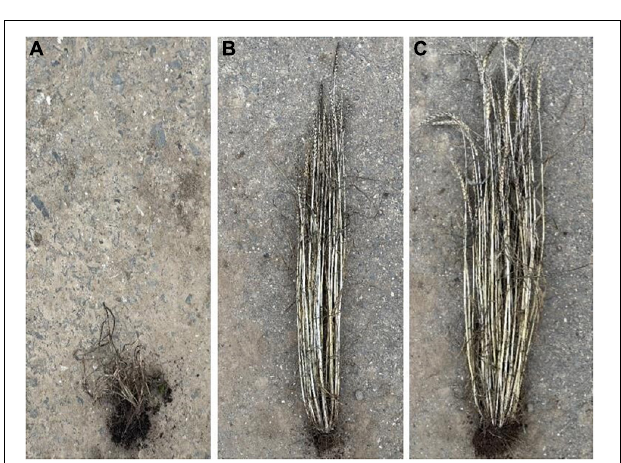
FIGURE 3 | Visual comparison of an infected “Hybnos” plant (A) after harvest of the gauze house test and two infected “Fisht” plants with a wheat dwarf virus (WDV) extinction value of E = 0.31 (B) and E = 0.03 (C) ,